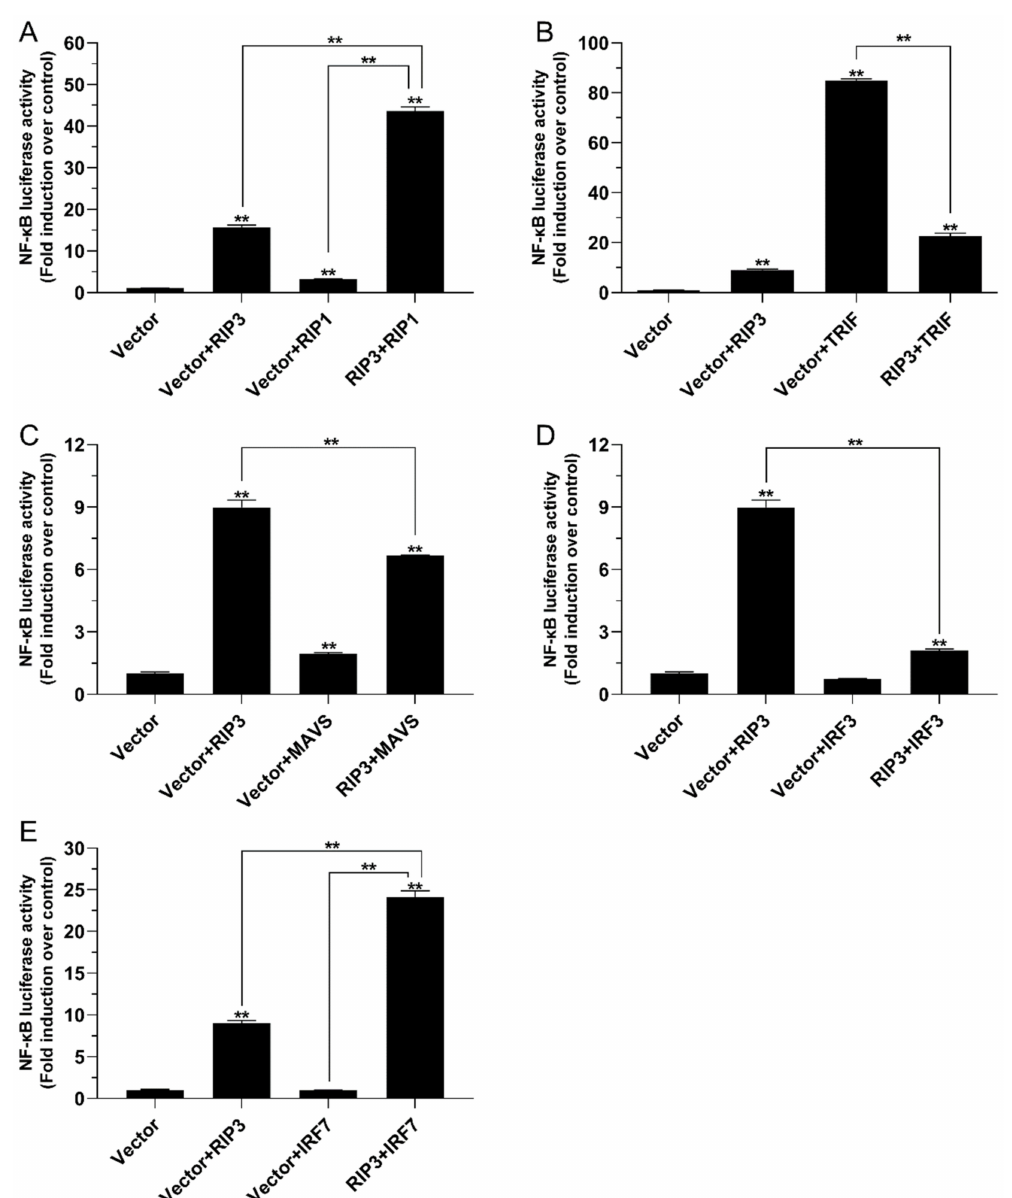
Figure 7. The role of Lc -RIP3 in the regulation of NF- κ B signaling. The associations of Lc -RIP3 with Lc -RIP1 ( A ), Lc -TRIF ( B ), Lc -MAVS ( C ), Lc -IRF3 ( D ), and Lc -IRF7 ( E ) in NF- κ B promoter activation were analyzed by luciferase reporter assays. HEK 293T cells were co-transfected with 100 ng of pNF- κ B-luc and 10 ng of pRL-TK together with 100 ng of pcDNA3.1-RIP3, pcDNA3.1-RIP1, pcDNA3.1-TRIF, pcDNA3.1-MAVS, pcDNA3.1-IRF3, and pcDNA3.1-IRF7 alone or in a combination of two with the total amount of transfected plasmids balanced by the pcDNA3.1 empty vector for each transfection. The cells were then harvested and lysed for the measurement of luciferase activities at 24 h post-transfection. All data were presented as mean ± SE from three independent experiments with the bars representing the SE. ** p <